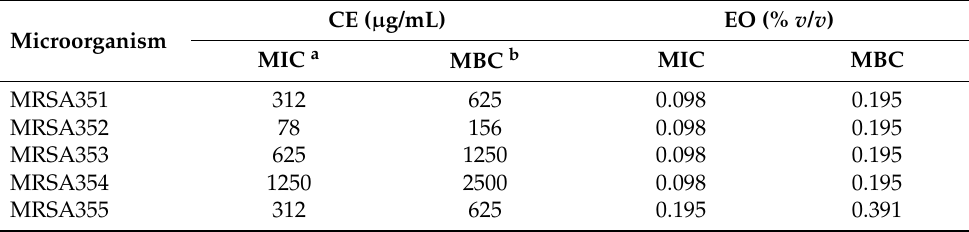
Table 4. Determination of MIC and MBC values using crude extract (CE) and essential oil (EO) against the